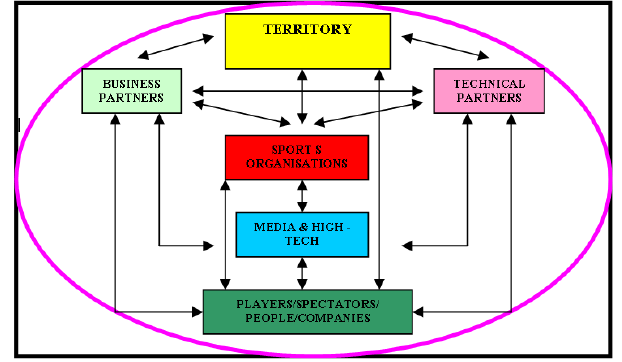
Figure 1: Components of the Sport